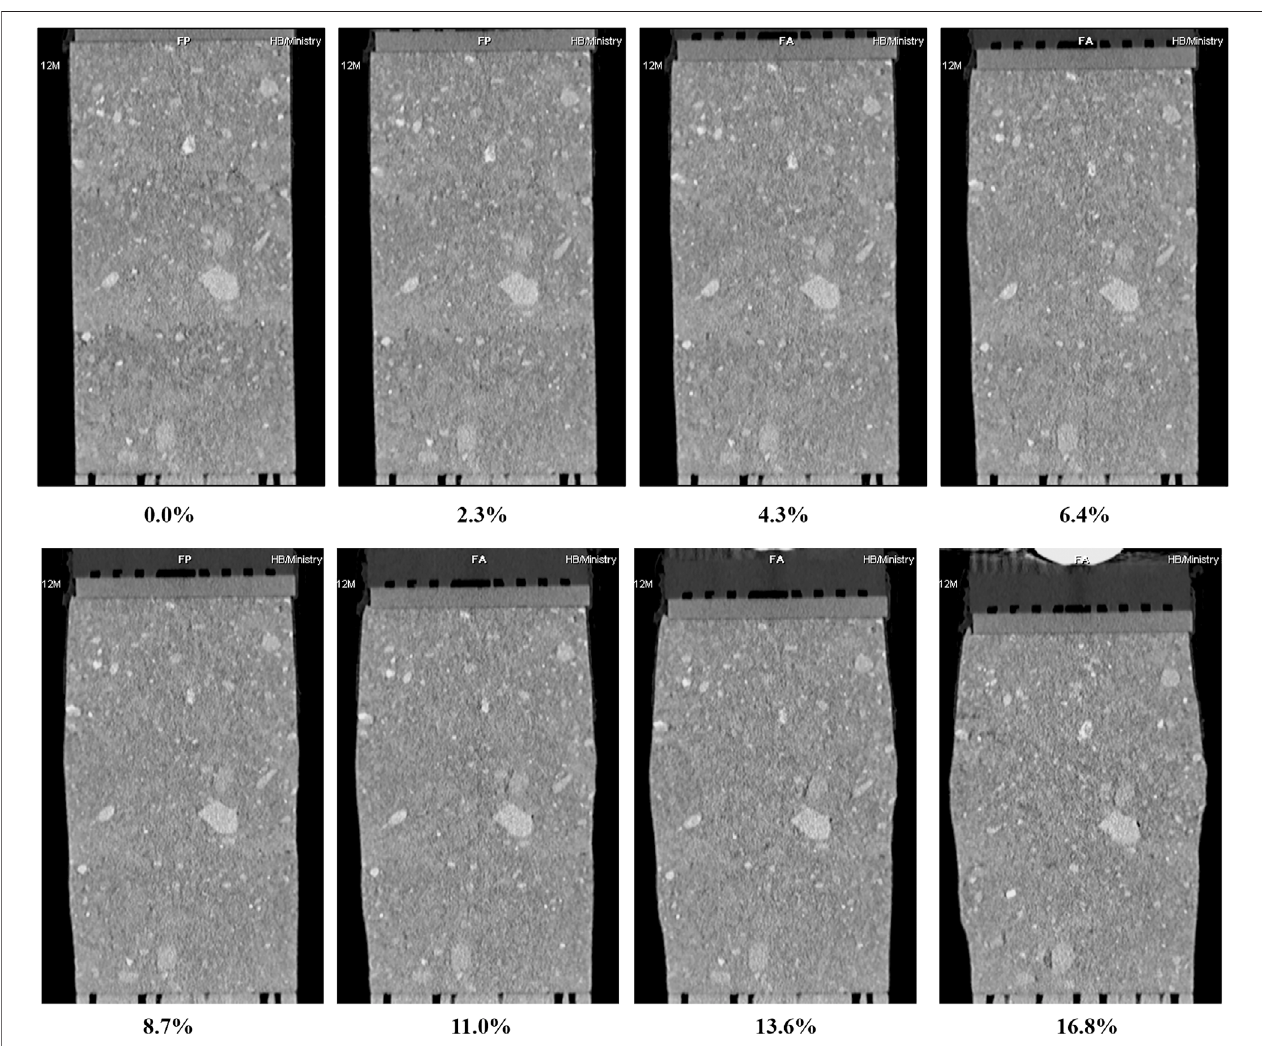
FIGURE 4 | CT triaxial test